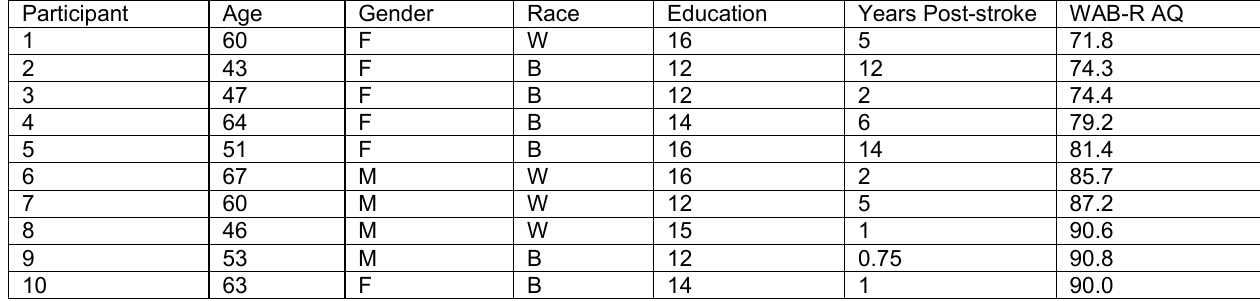
Demographic Data and WAB-R Aphasia Quotient (AQ) Scores